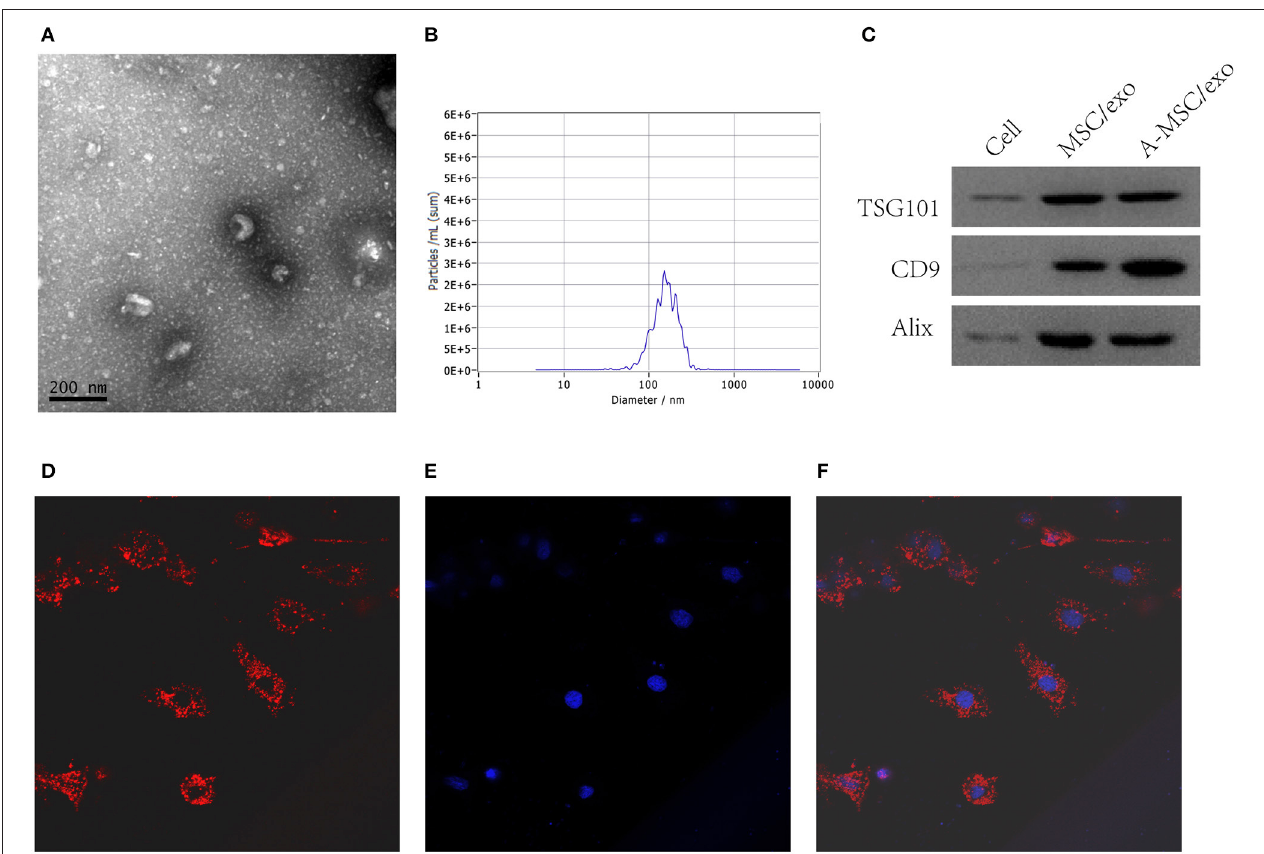
FIGURE 4 | Isolation and identification of exosomes from MSCs. Exosomes were isolated from MSC culture supernatants. (A) TEM image of exosomes. (B) Nanosight analysis for the particle size. (C) Detection of CD9, TSG101, and Alix by Western blotting. (D) Confocal scanning laser microscopy showing PKH-26-labeled exosomes internalized by VSMCs (200 × ). (E) DAPI. (F) Merge.